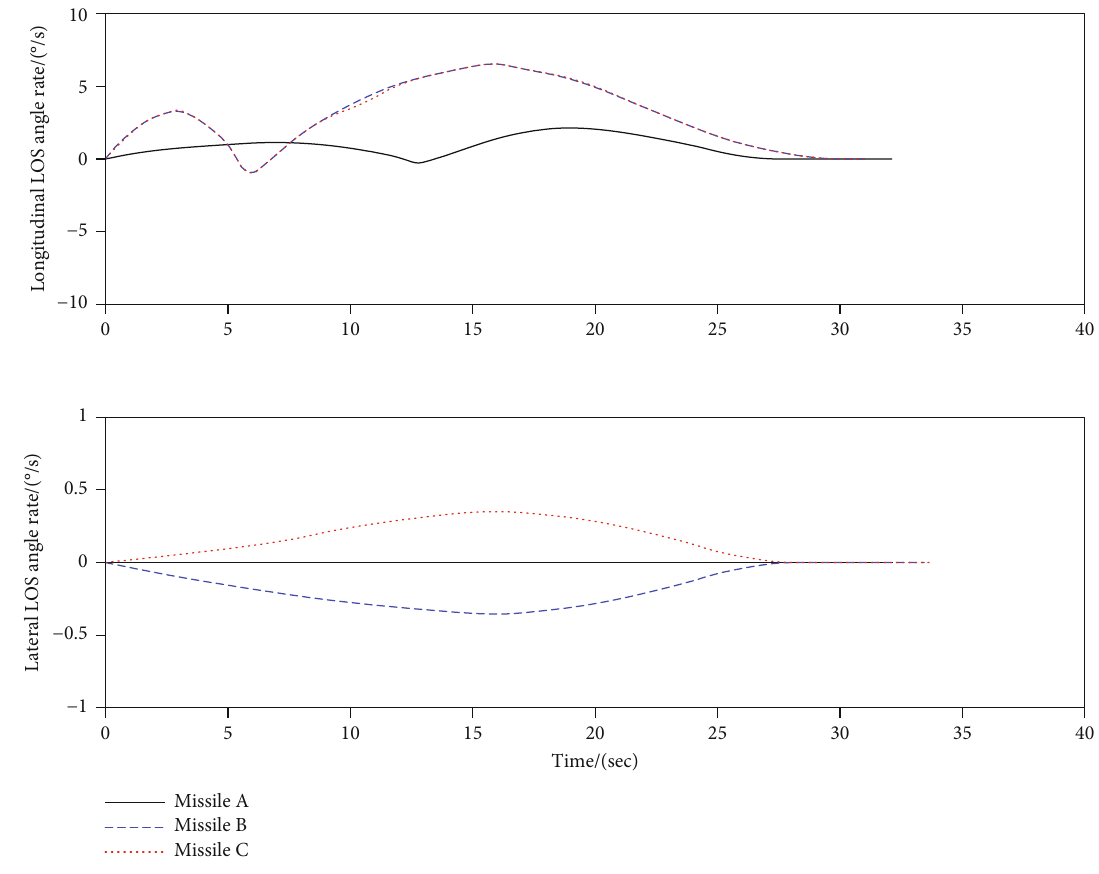
Figure 8: LOS angle rate curves in the longitudinal plane and lateral plane of three missiles. Table 4: Performance comparison of three